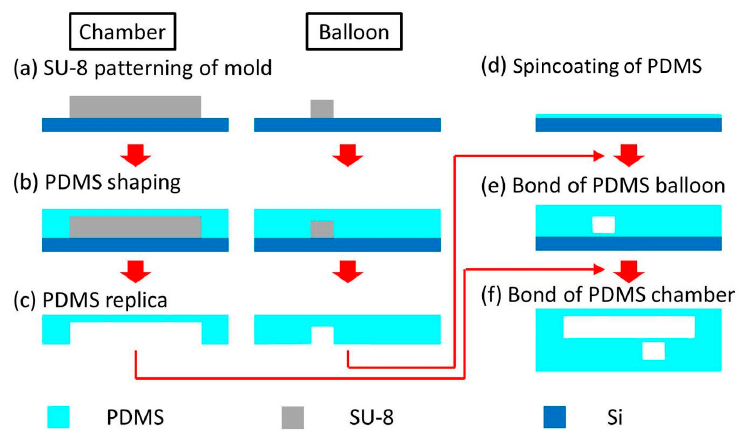
Figure 3. Fabrication process of a microfluidic high-migratory cell collector. ( a ) SU-8 patterning of the molds for a balloon and a microchamber. ( b ) polydimethylsiloxane (PDMS) shaping of a balloon and a cell culture microchamber. ( c ) PDMS replica of a balloon and a microchamber. ( d ) Spincoating of PDMS. ( e ) Bond of a thin membrane to a PDMS balloon. ( f ) Bond of the PDMS structure made in (e) to a PDMS cell culture microchamber.